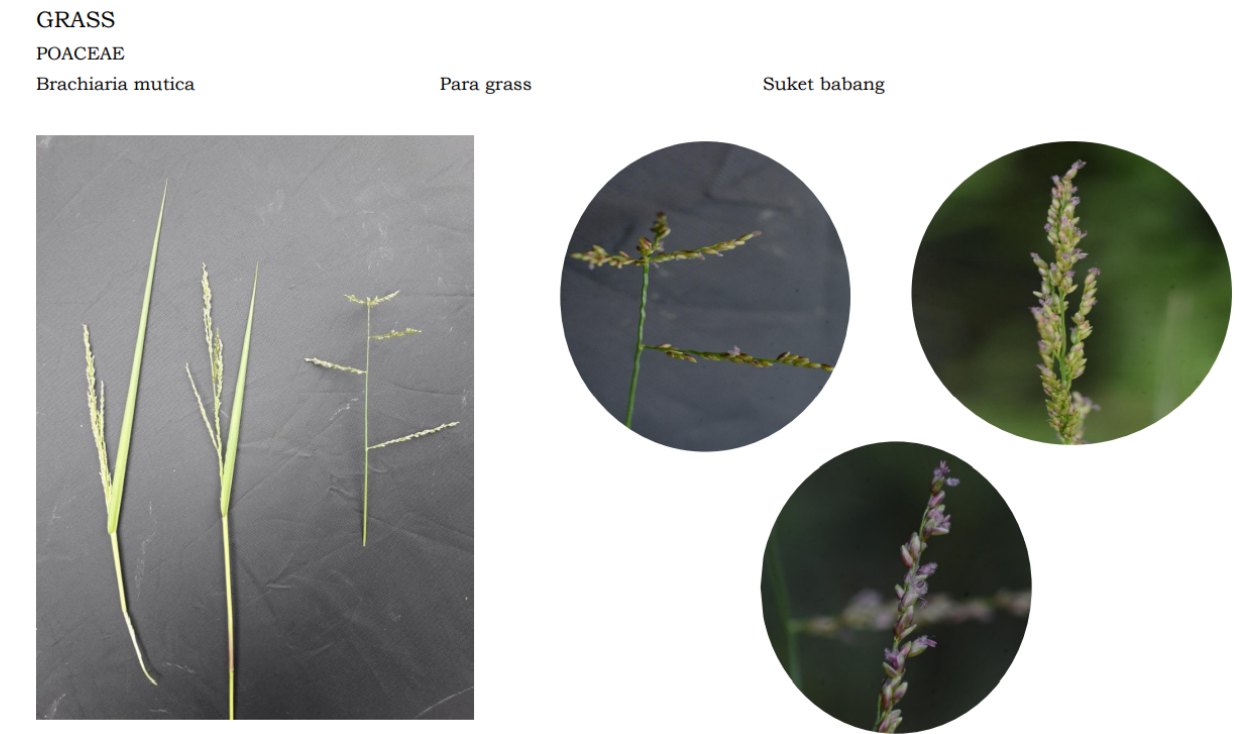
Figure A9. Creeper Fabaceae: Mimosa pudica.